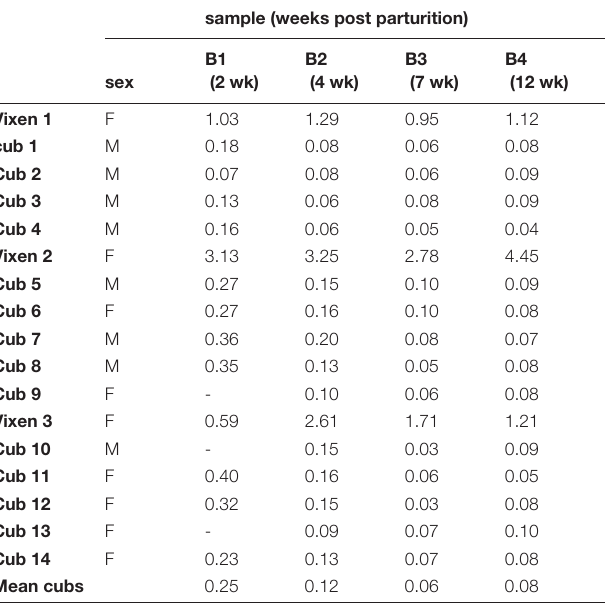
taBle 3 | Serology results (IU/ml) of the blood samples taken from the foxes, vixens and their cubs (RFFIT); the vixen was vaccinated by the oral route during early pregnancy ( -, sample not